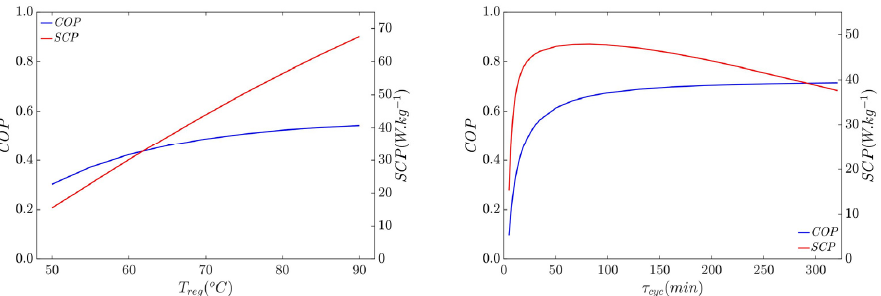
Figure 5. COP and SCP variation with the regeneration temperature (on the left ) and the cycle time (on the right ). (on the ( right